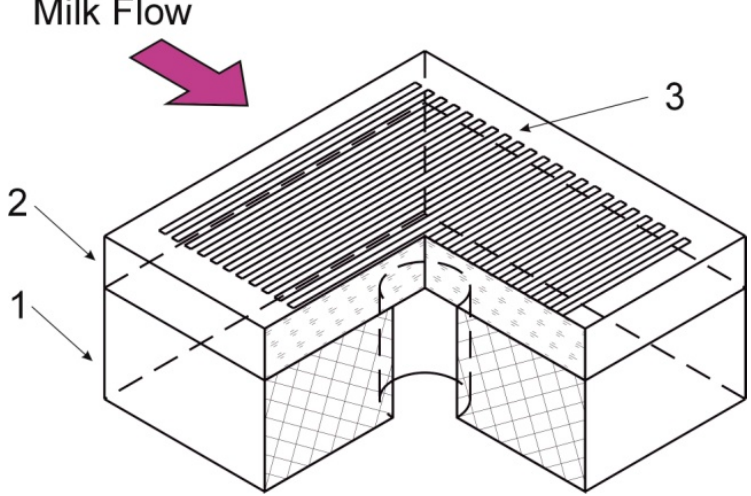
Figure 5. Design of a raster: (1) opaque plastic base with a cylindrical aperture, (2) transparent plane-parallel optical glass, (3) metal strips made on the glass surface by Ni-Cr alloy deposition. We employed two replaceable rasters with a stripe width of 100 and 200 micron.